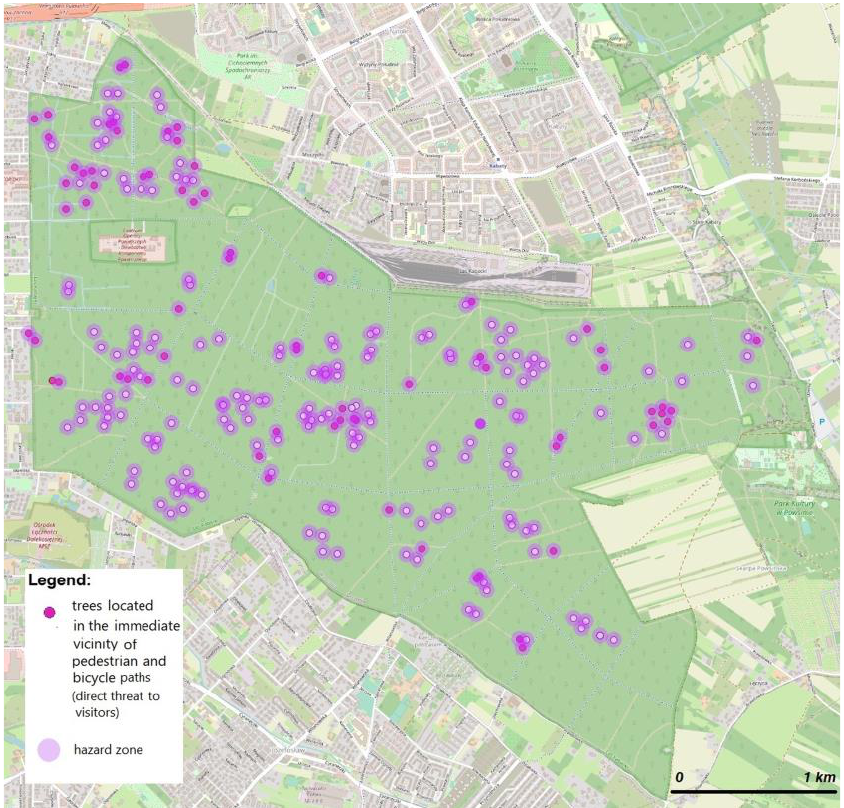
Figure 8. The risk map of the Bielański forest with hazard zones for ill trees (author’s elaboration based on the High Structural Diversity Tree Crown Map database [77]).